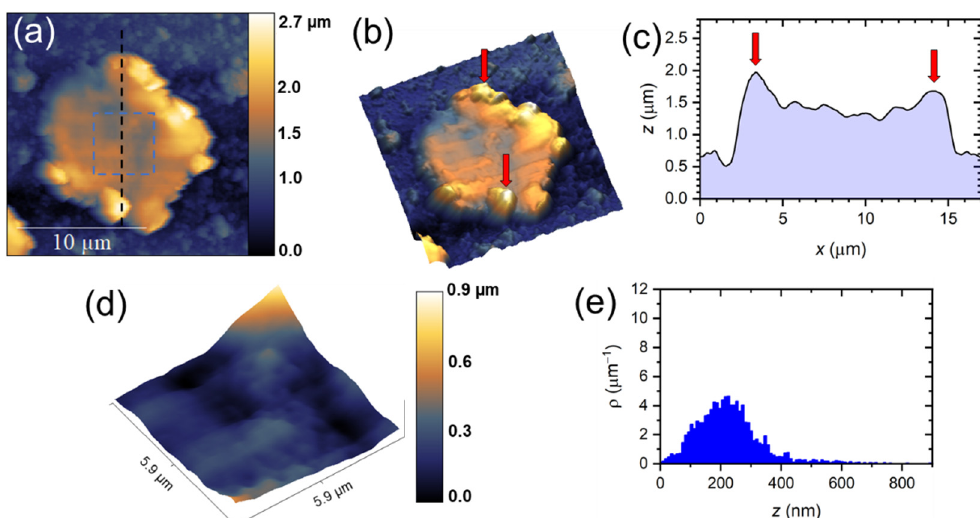
Figure 3. Representative AFM image of an acute lymphoblastic leukemia cell cultured on the TiO 2 -m coating for 20 min. ( a ) Two-dimensional and ( b ) three-dimensional topography images, showing cell contraction without defined anchor points. ( c ) Height profile taken along the dashed line in ( a ). The red arrows indicate some TiO 2 -m nanoparticle aggregates close to the membrane boundary. ( d ) Three-dimensional representation of the zoomed area indicated by the dashed square in ( a ). ( e ) Height distribution function calculated for the zoomed image shown in ( d ). The height z = 0 nm corresponds to the lowest height value within the zoomed region in ( d ).